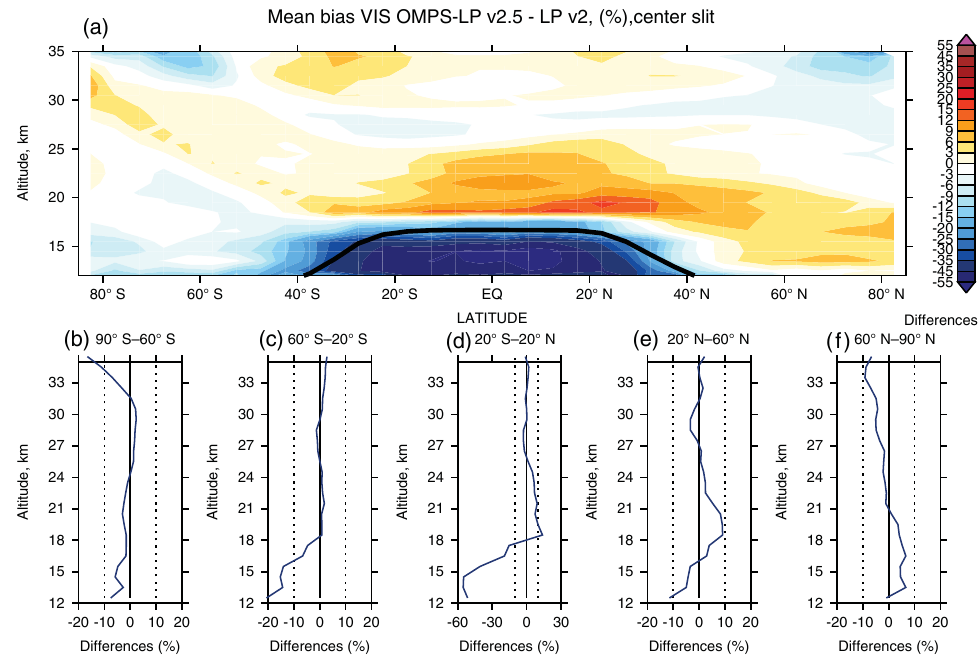
Figure 5. Same as Fig. 5 but for the VIS ozone retrievals in the vertical range between 12.5 and 35.5km.